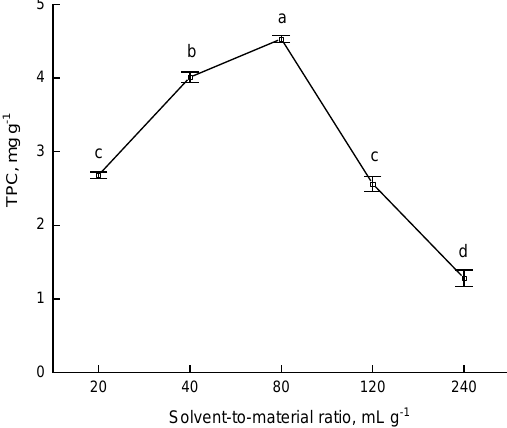
Figure A2. Effect of pH on the extraction of phenolic compounds from apple pomace (C(Tween 80) 1%, time 60 min, solvent-to-material ratio 80 mL g −1 ). Different lower case letters indicate significant differences among treatments ( p ≤ 0.05) based on post hoc Tukey’s test.